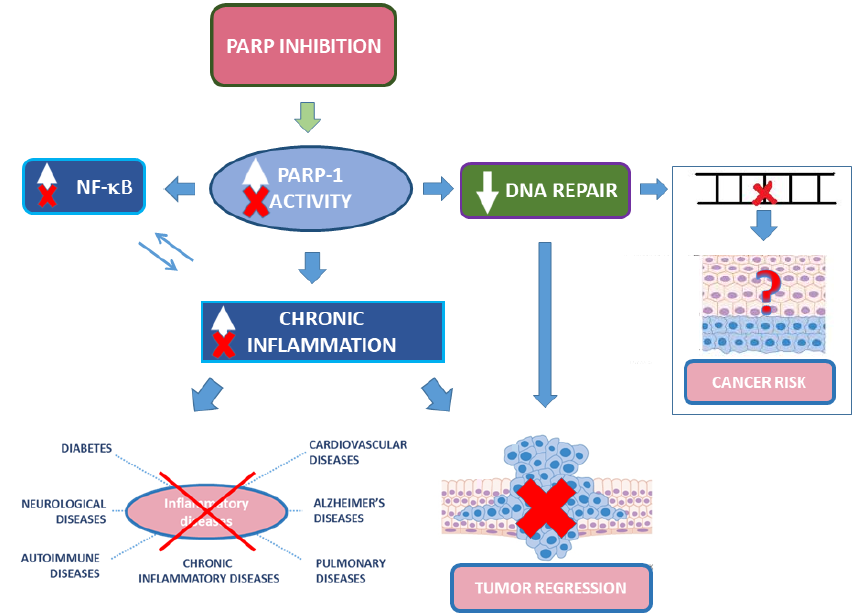
Figure 3. Schematic representation of the e ff ects of PARP inhibition on cancer and inflammatory-related diseases. PARP inhibition reduces NF- κ B activation and inflammation, with beneficial e ff ects in inflammatory diseases and cancer. Yet, inhibition of DNA damage recognition and repair, although beneficial in cancer therapy, might increase cancer risk.